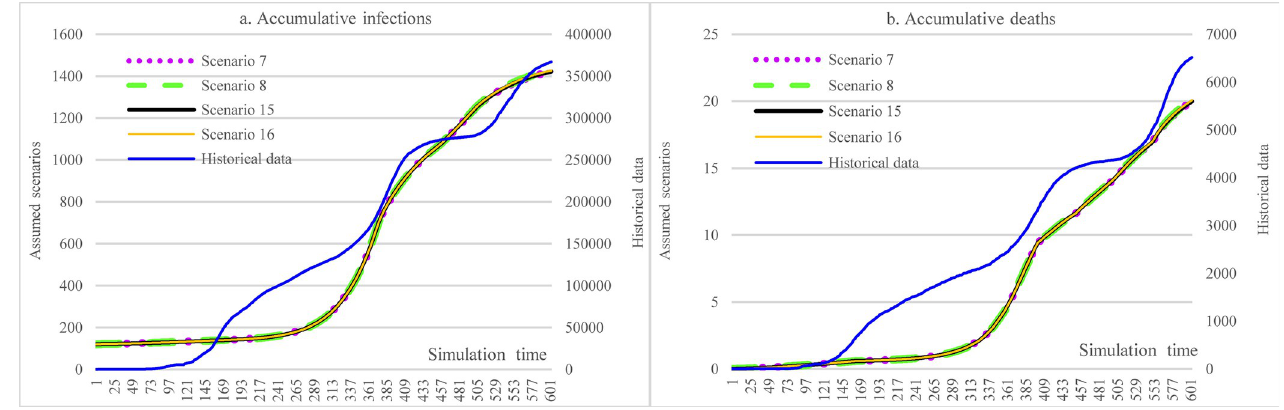
Fig 7. Impacts of increasing face mask-wearing in counterfactual analysis.